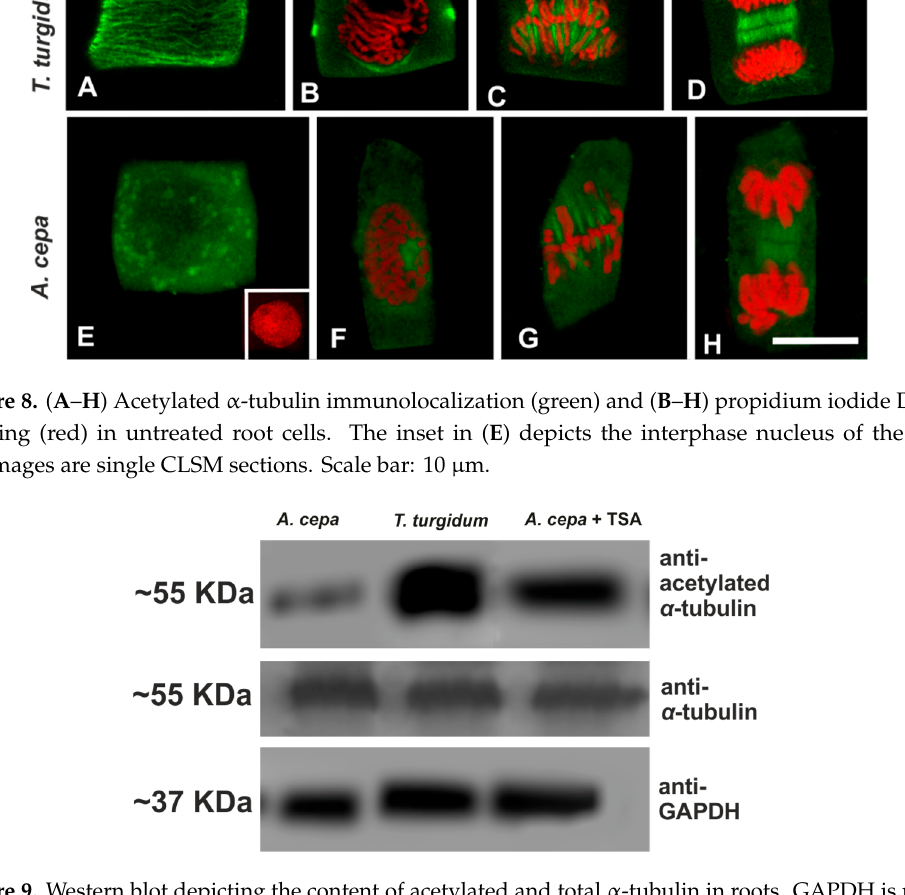
Figure 9. Western blot depicting the content of acetylated and total α -tubulin in roots. GAPDH is used as a loading control. TSA: trichostatin A.